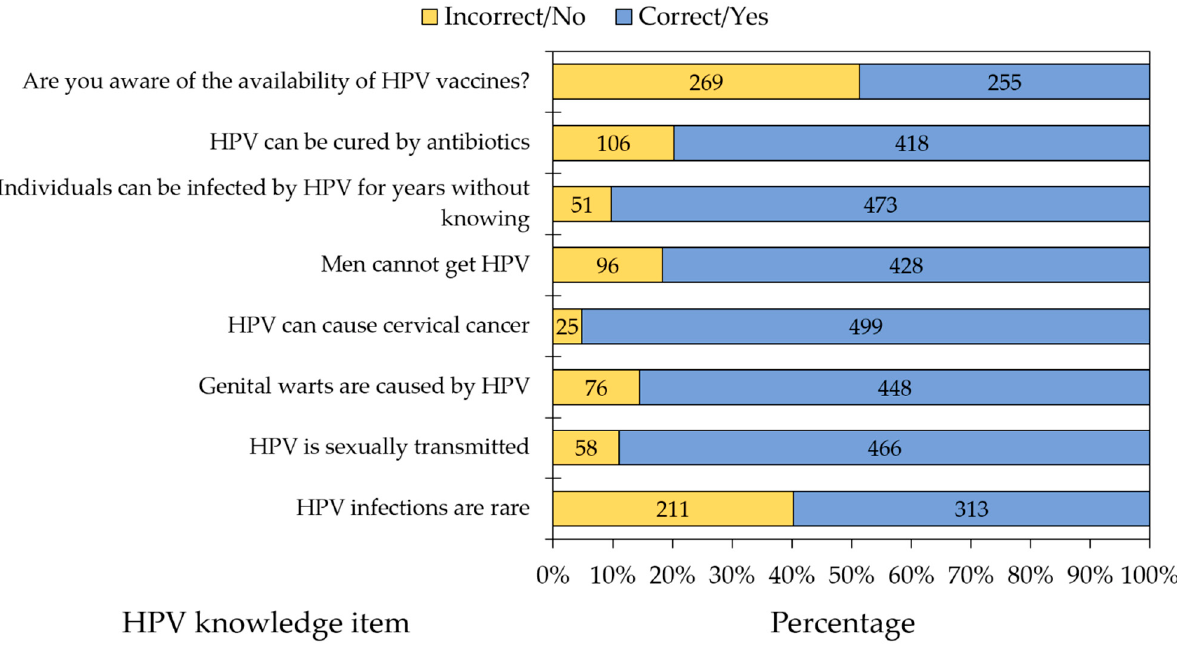
Figure 2. Overall knowledge regarding human papillomavirus among the study participants who have heard of HPV prior to the study (524/854), divided per knowledge item. Table 2. Human papillomavirus (HPV) level of knowledge stratified based participant affiliation to different schools/fac- ulties.